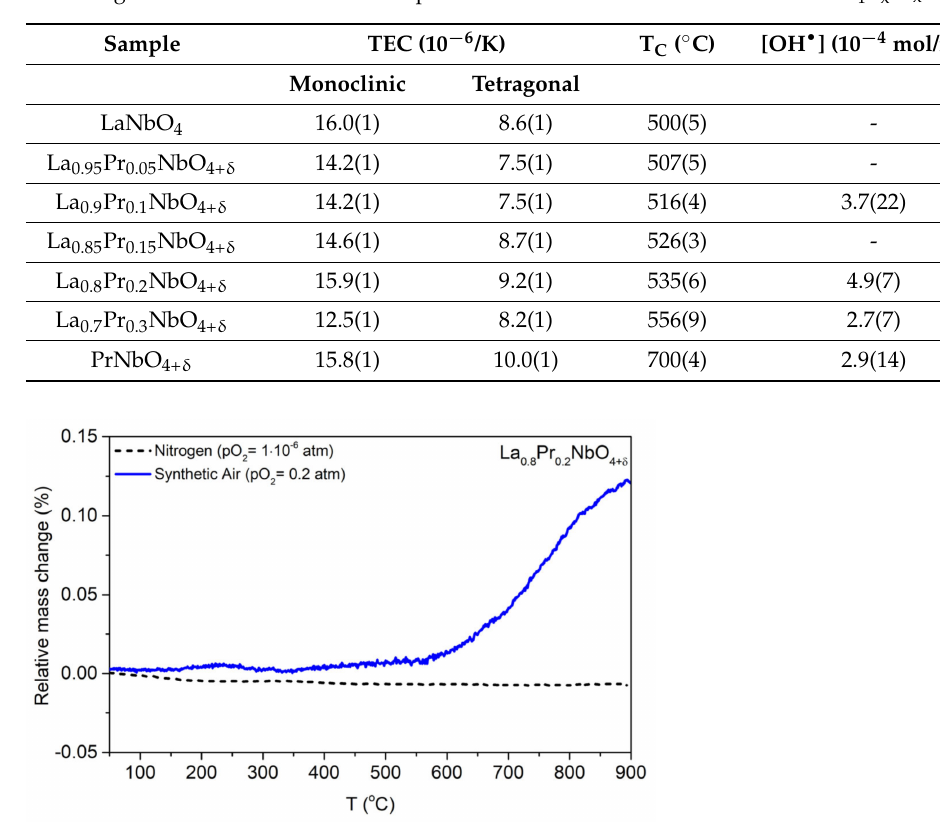
Figure 7. The relative mass change of La 0.8 Pr 0.2 NbO 4+ δ as a function of temperature in air and nitrogen.